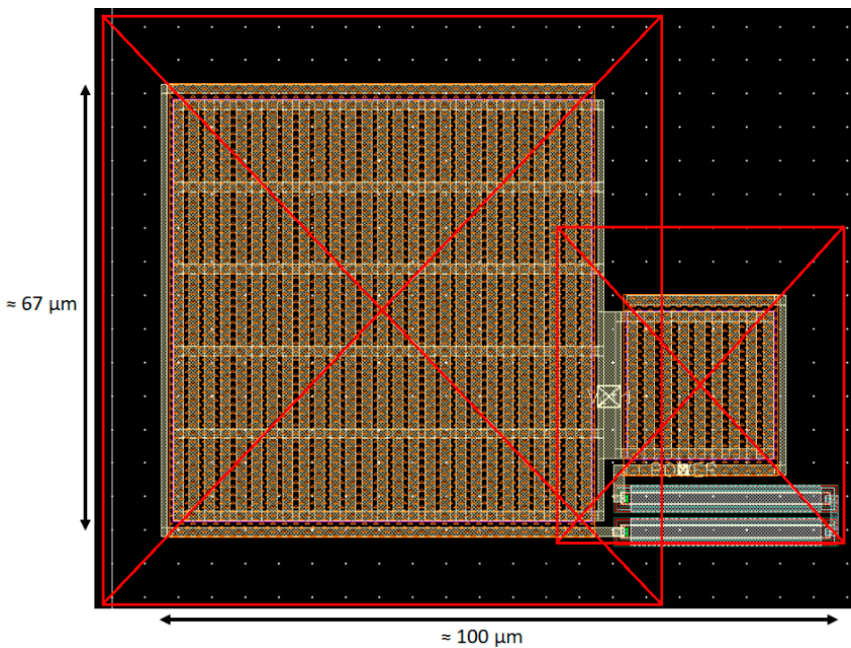
Figure 6. Layout in 65 nm technology of the Loop Filter in Figure 2.